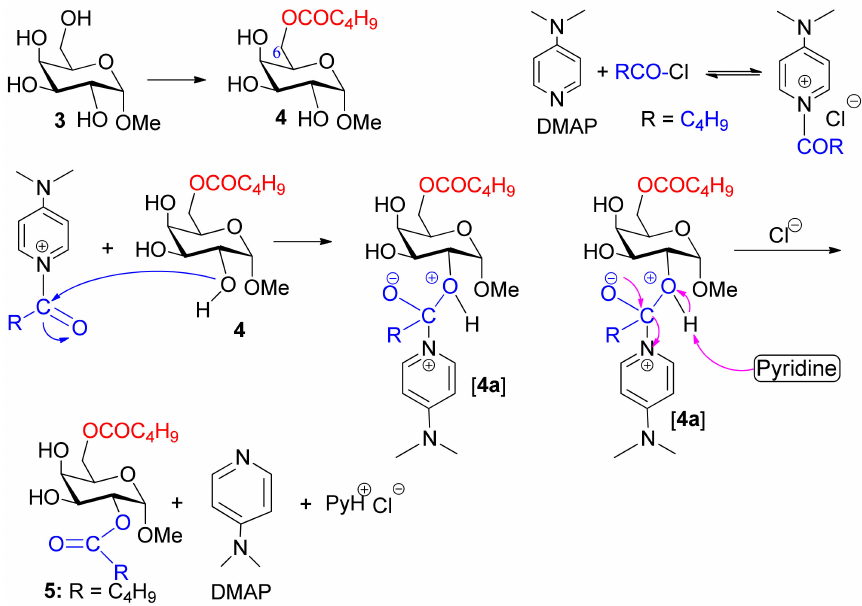
Figure 2. Probable mechanism of DMAP-catalyzed 2,6-di- O -valeroate 5